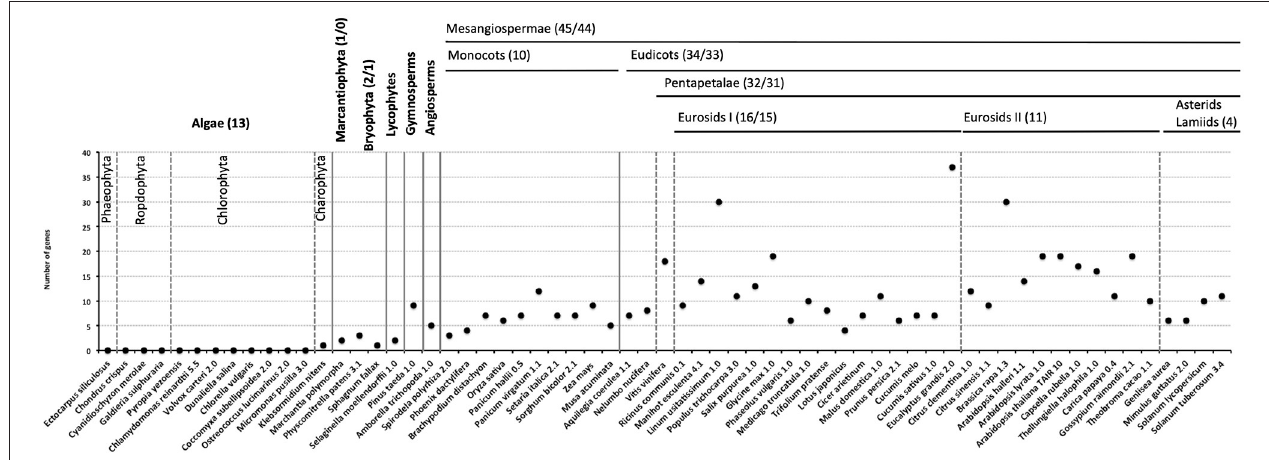
FIGURE 1 | The number of early response to dehydration six-like (ESL) proteins identified in each species. The classification of the species is indicated at the top of the graph. Numbers in bracket indicate the total sequence number/the number of sequences included in a phylogenetic analysis.